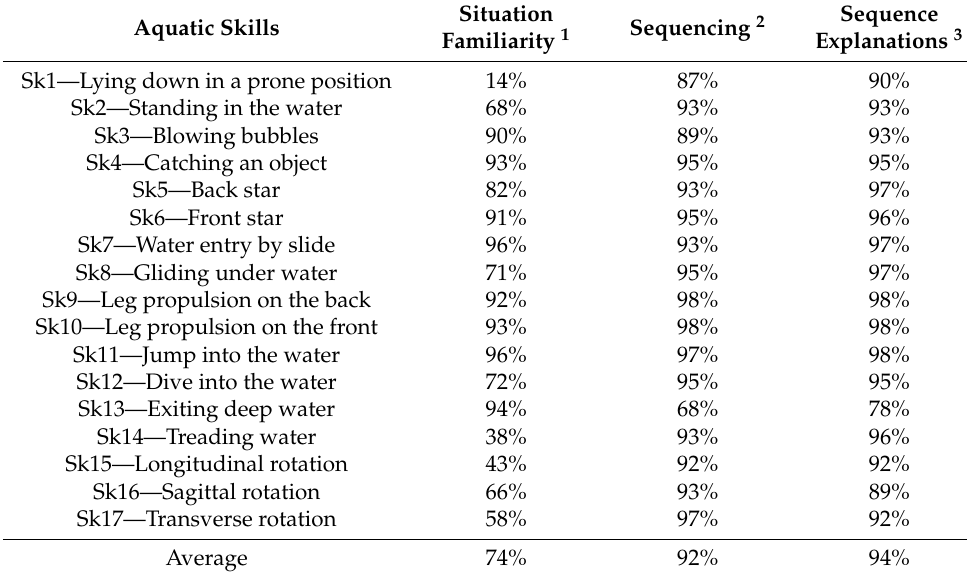
Table 2. Face validity of the PSPWC: situation familiarity, ability to sequence and to explain the sequence by the